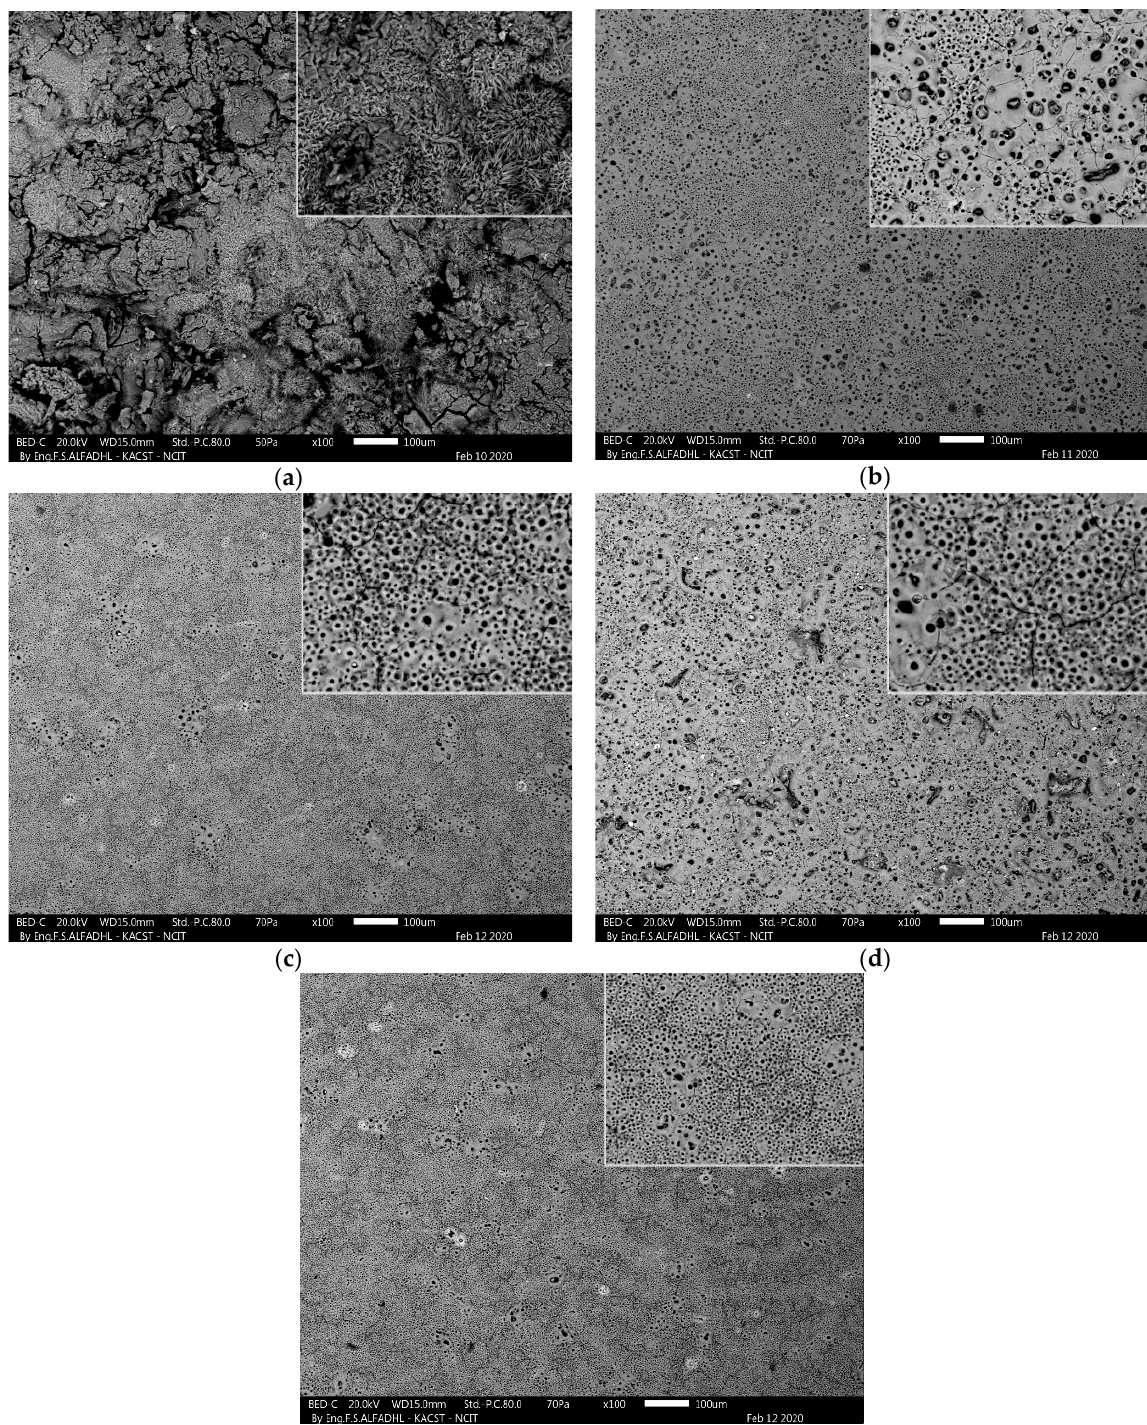
Figure 5. SEM micrographs for the AM60 alloy after the corrosion test at low and high magnification: ( a ) BM, ( b ) UP, ( c ) BP30, ( d ) BP50 and ( e ) BP66.